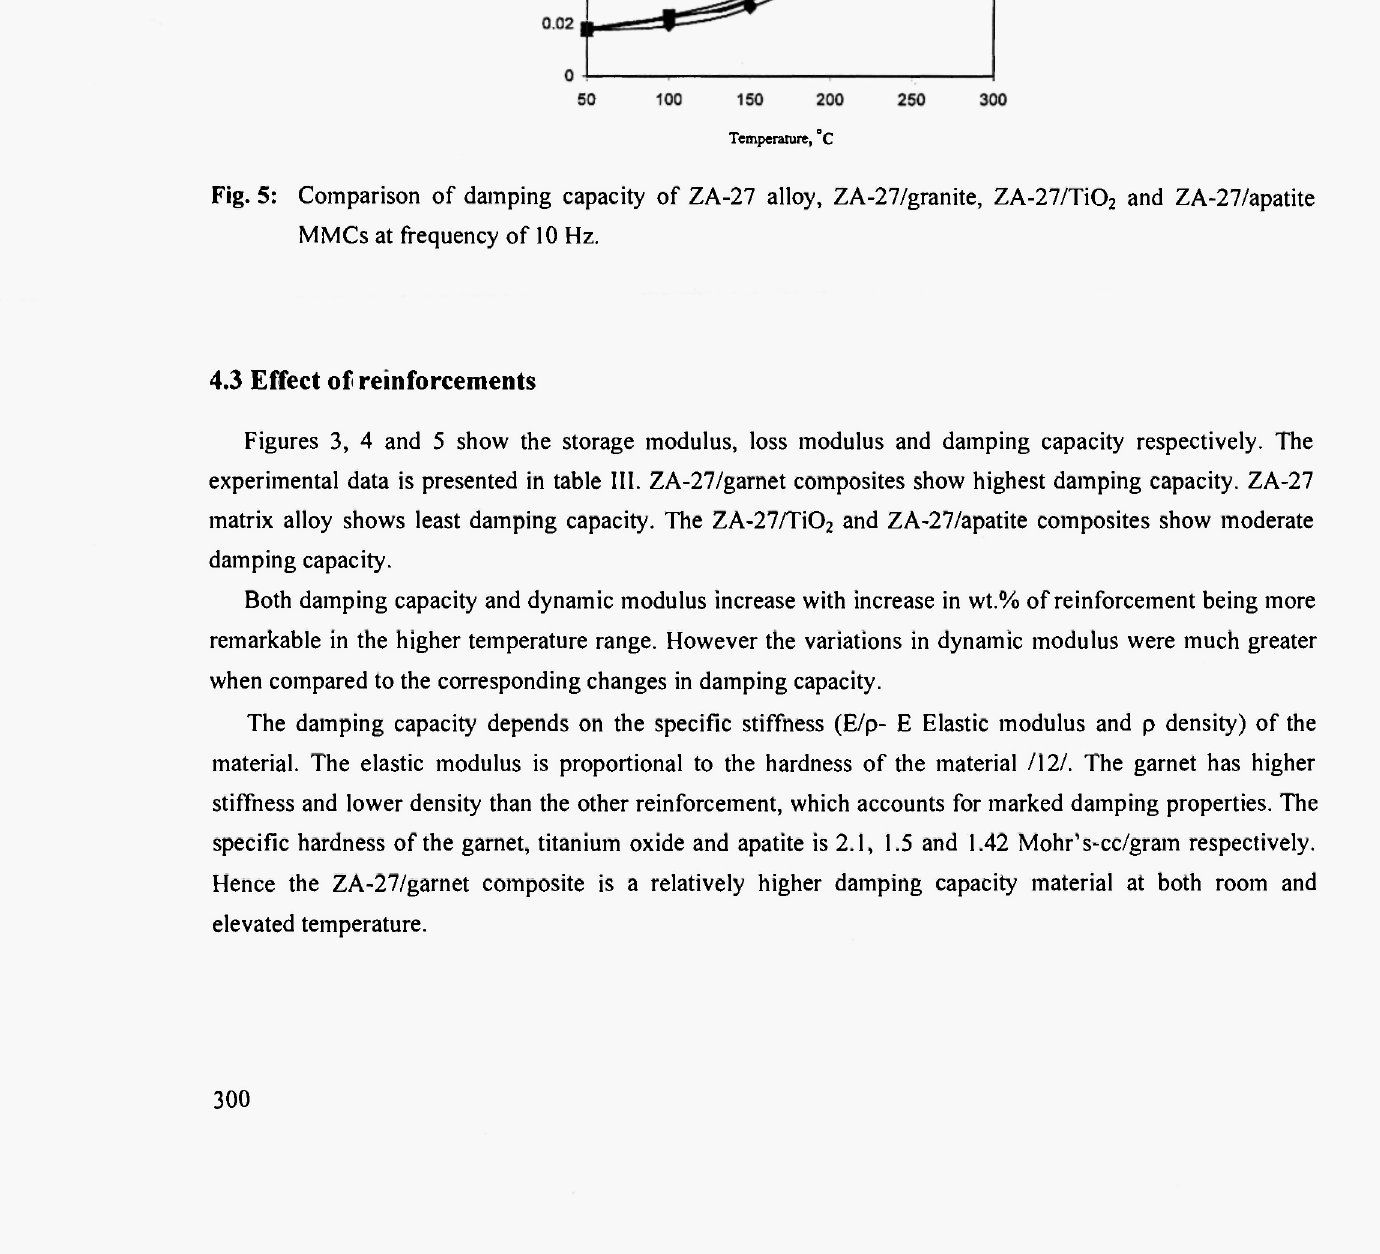
Fig. 5: Comparison of damping capacity of ZA-27 alloy, ZA-27/granite, ZA-27/Ti0 2 and ZA-27/apatite MMCs at frequency of 10